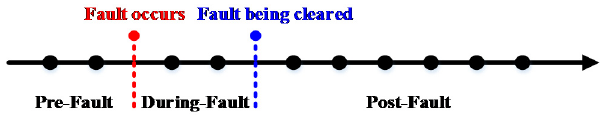
Figure 1. Three-time stages related to transient stability.